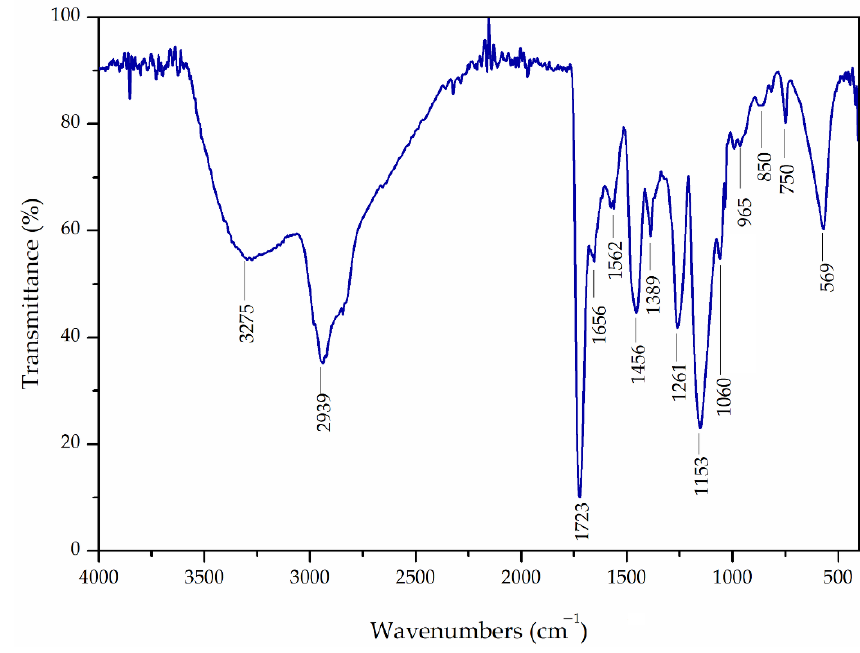
Figure 2. ATR-FTIR spectra of Fe 3 O 4 @APTMS/PGME-deta nanocomposite.